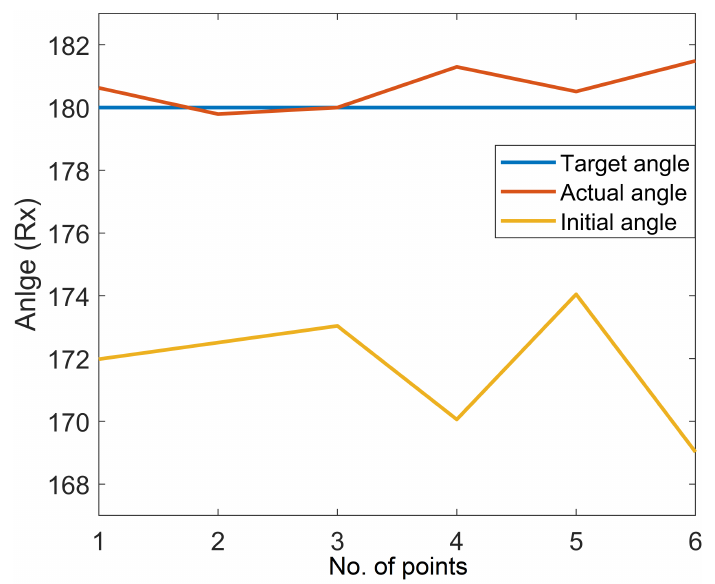
Figure 8. Movement of the robot along x- and y-axes.